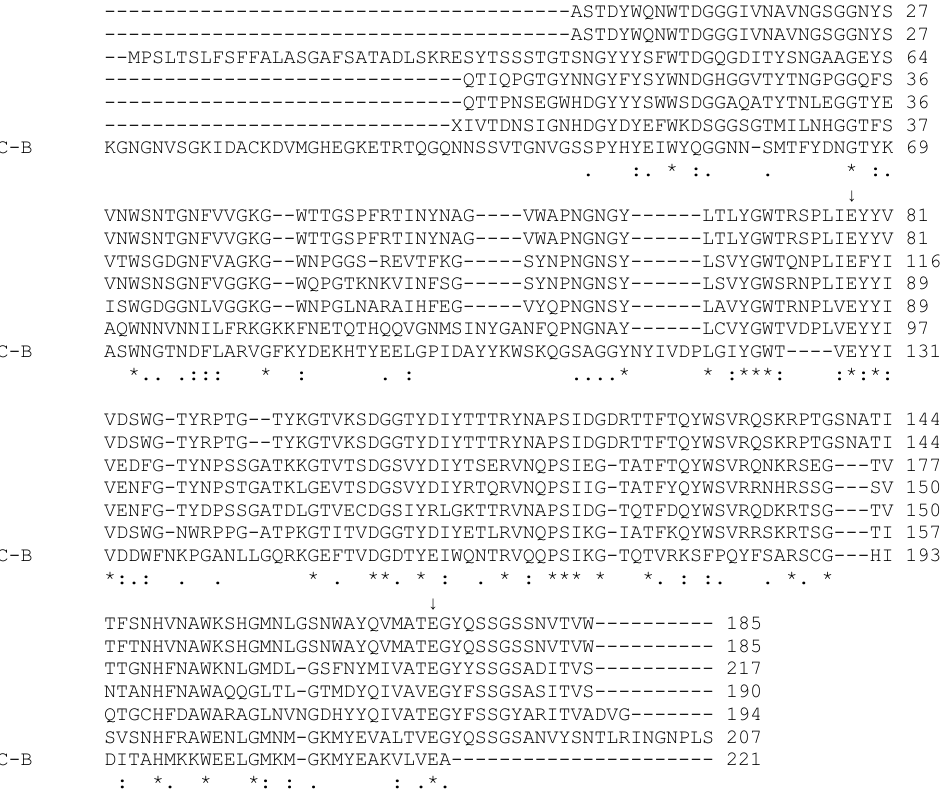
Figure 3. Clustal W 2.1 xylanase multiple sequence alignment [114]. The catalytic Glu residues are indicated with arrows. Identical residues for all sequences are given by “*”, while conserved and semi-conserved substitutions are given by “:”and “.”